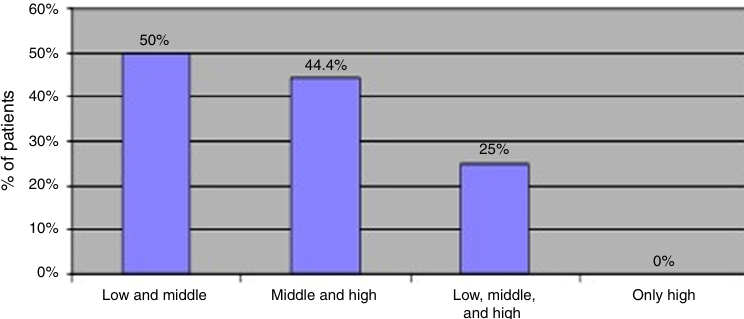
Figure 1 Distribution of significant hearing recovery percentage by groups of affected frequencies.